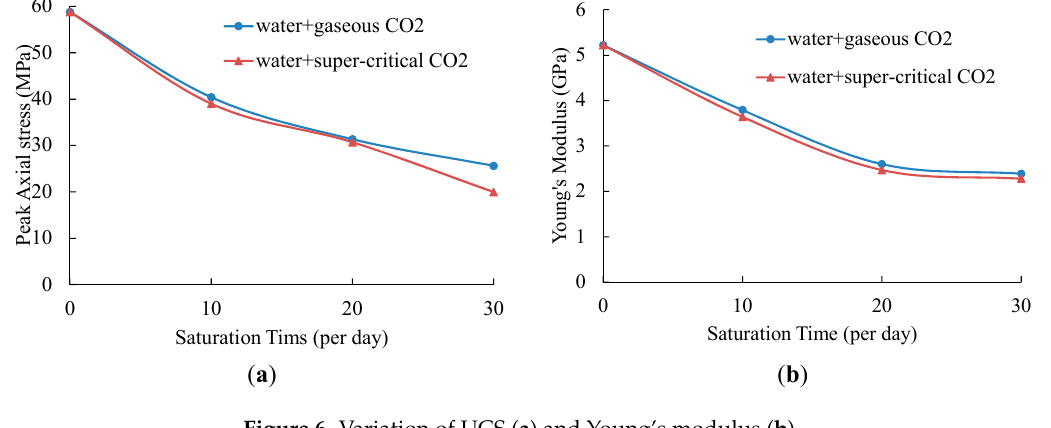
Figure 6. Variation of UCS ( a ) and Young’s modulus ( b ). Table 4. Comparison of physical properties of gaseous CO 2 (7 MPa, 40 °C) and SC-CO 2 (9 MPa, 40 °C) and their dissolution abilities in water [32,44,45].